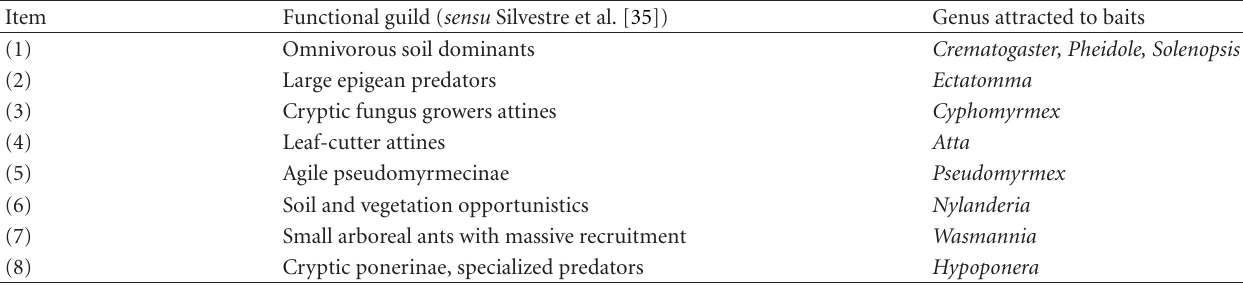
Table 5: Ant genus classification of ants attracted to baits into the functional groups established by Silvestre et al. [35]. Item Functional guild ( sensu Silvestre et al.